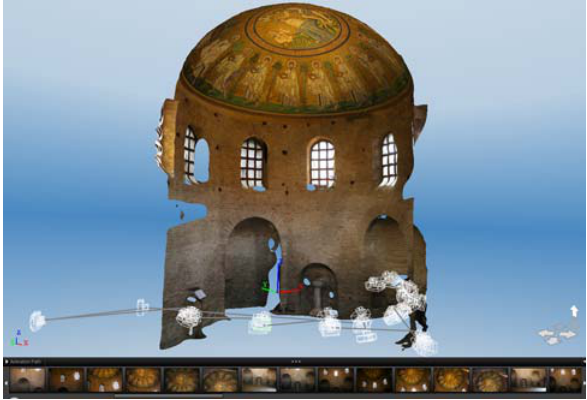
Figure 2. Capturing of convergent sets of images inside the Battistero degli Ariani.